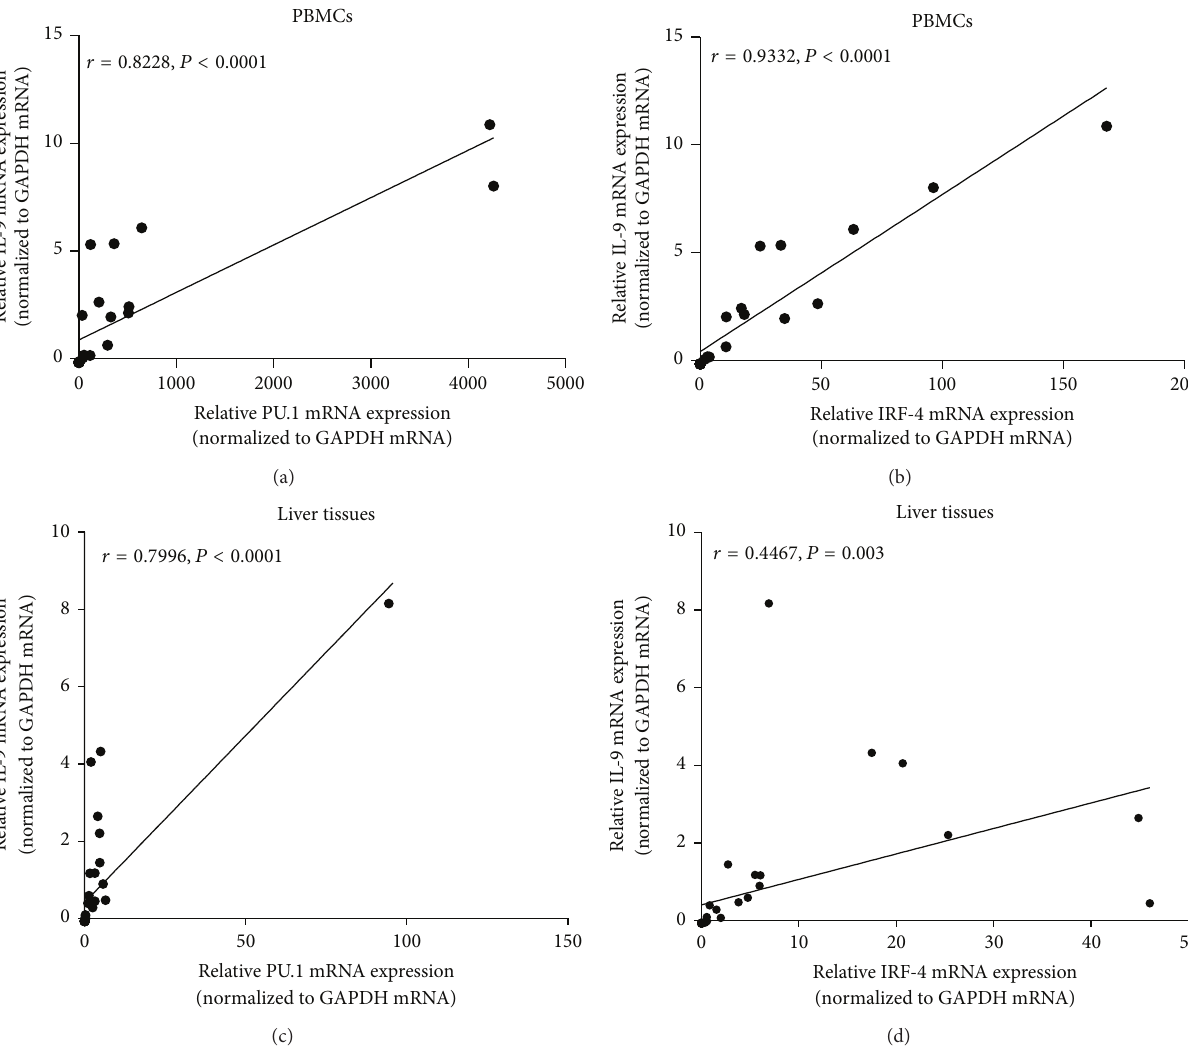
Figure 4: Spearman correlation of Th9 cells cytokine and transcription factors in PBMCs and liver tissues. ((a) and (b)) IL-9 mRNA expressions in PBMCs were correlated positively both with PU.1 and with IRF-4 mRNA expressions ( 𝑟 = 0.8228 , 𝑃 < 0.0001 ; 𝑟 = 0.9332 , 𝑃 < 0.001 , resp.). ((c) and (d)) The expression of IL-9 mRNA in liver tissues had a positive correlation with both PU.1 and IRF-4 mRNA expression ( 𝑟 = 0.7996 , 𝑃 < 0.0001 ; 𝑟 = 0.4467 , 𝑃 = 0.003 ,